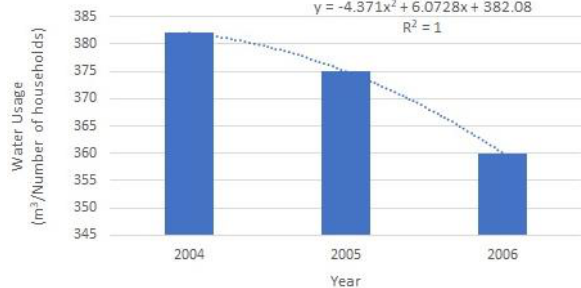
Fig. 4. Water use before implementation of progressive tariffs